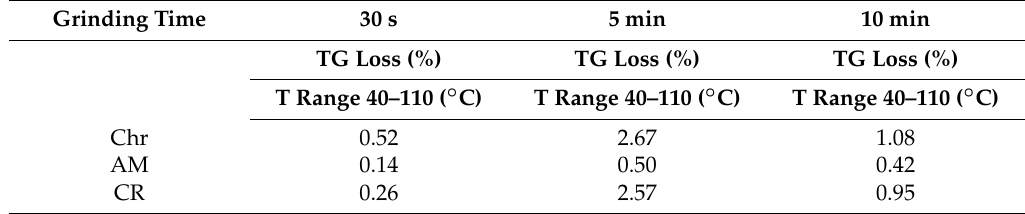
Table 2. Thermogravimetric, mass loss (%) for chrysotile (Chr); amosite (AM); crocidolite (CR) in the range of 40–110 ( ◦ C) after grinding for 30 s, 5 min and 10 min.